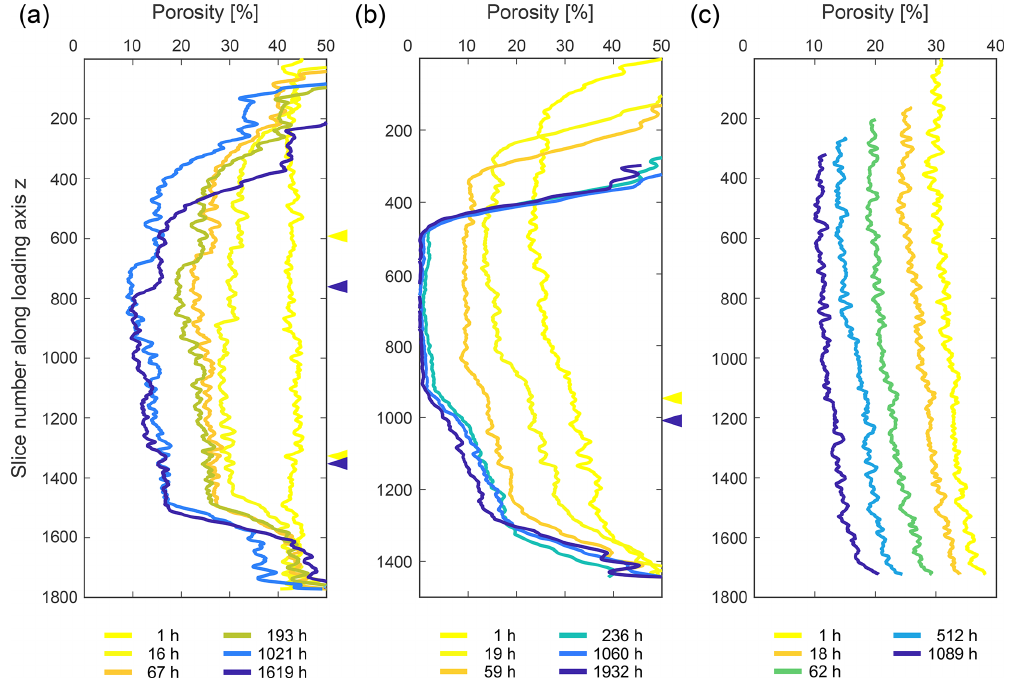
Figure 13. Porosity evolution of (a) the SBS (b) the SB sample and (c) the pure NaCl sample with progressing deformation. The porosity was measured as two-dimensional porosity for each slice along the loading axis. Different colours indicate different time steps, ranging from yellow to blue with progressing compaction. While heterogeneities arise in panels (a) and (b) which show the compositionally layered samples, panel (c) shows a homogeneous decrease of the porosity within the sample. The highest porosity loss occurs in biotite-bearing layers, resulting in the compartmentalisation of the SB sample (see Sect. 2.5). Note that the arrows on the right-hand side mark the transition from the pure NaCl domain to the NaCl–biotite domain, and colours correspond to the deformation stage as denoted in the